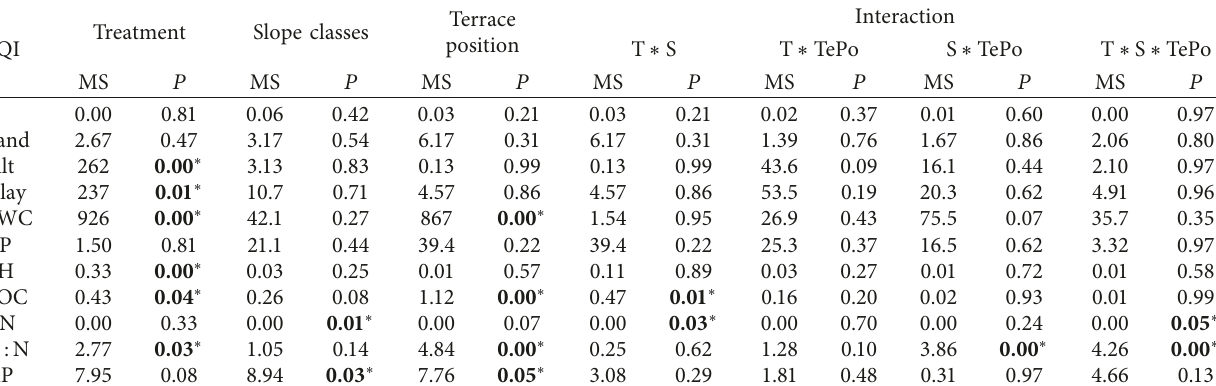
Table 6: Results of the analysis of variance of soil quality indicators across the treatments, slope positions, and positions within the terraces in the Geshy